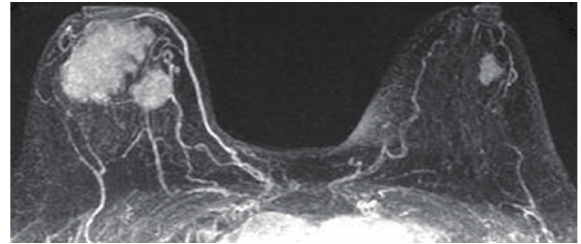
Figure 2: Magnetic resonance imaging of the breast dense microlobulated masses with irregular margins, 43 × 52 × 37 mm and 17 × 23 × 14mm, were seen in the CDA and A areas of the right breast, respectively. In the C area of the left breast, a similar characteristic mass, 11 × 20 × 15mm, was also seen.